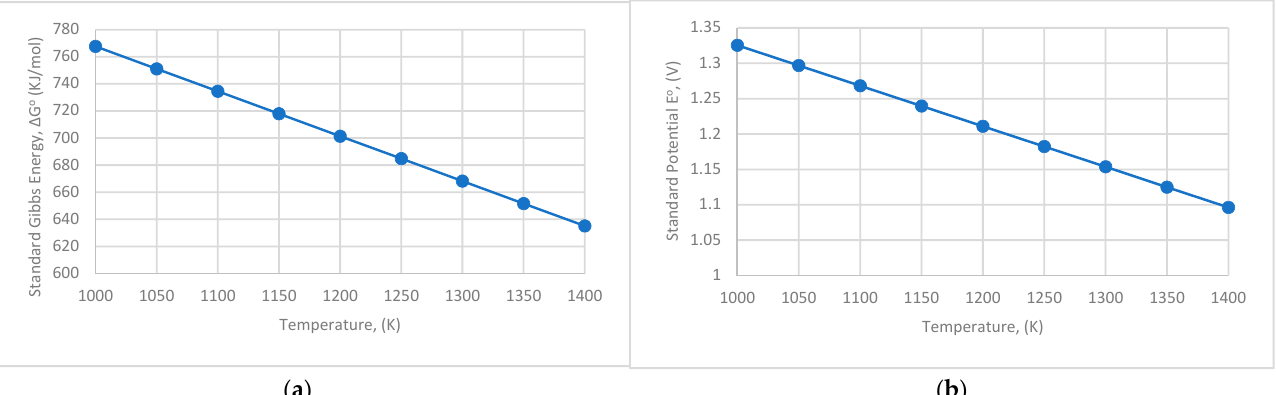
Figure 2. ( a ) Gibbs energy in relation to temperature; ( b ) standard aluminium electrolysis potential in relation to temperature